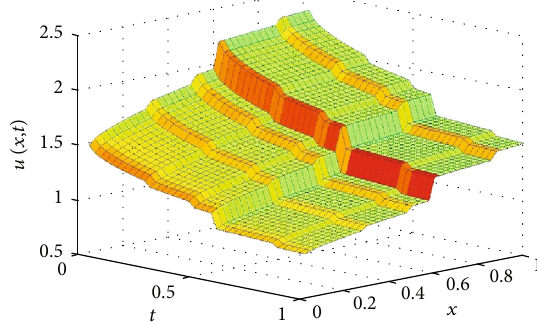
Figure 4: Variation of u ð x , t Þ versus x , t , with α = ln 2/ln 3 .